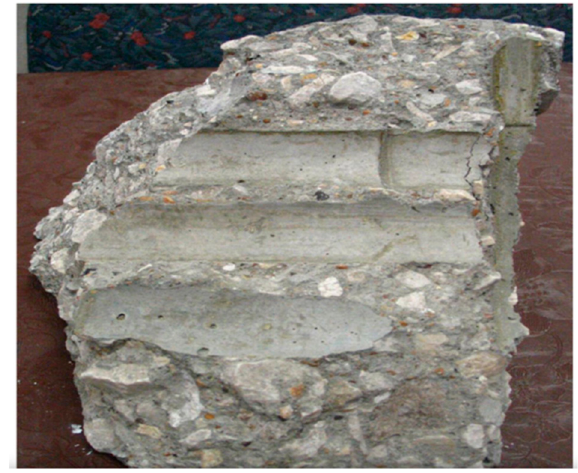
Figure 12. Imprint of bamboo reinforcement in cementitious material [51].